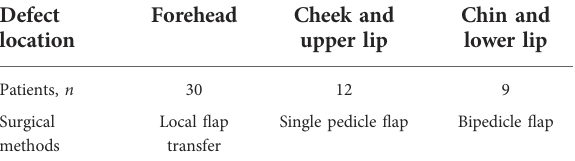
TABLE 2 The location of the defects and the surgical method of the patients.